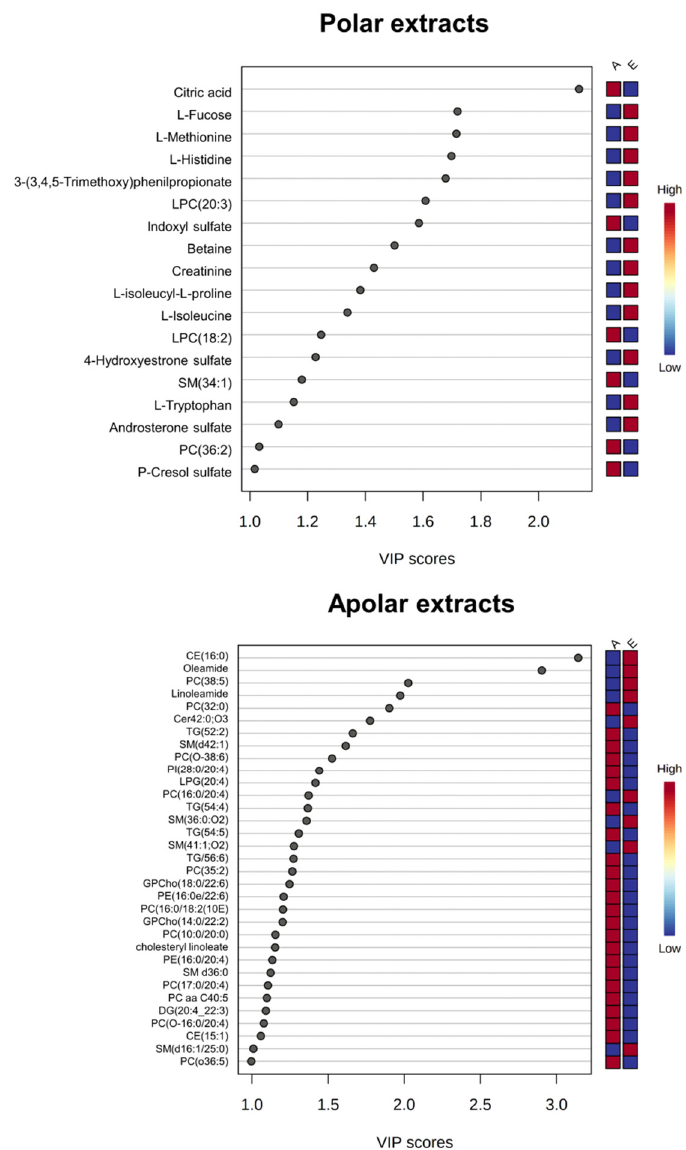
Figure 3. O-PLS-DA VIP graphs for the HRMS data collected using ESI (+) and ( − ). Data are relative to polar ( top ) and apolar ( bottom ) serum extracts of early compared to advanced ALS patients. The color code indicates higher (red) or lower (blue) concentrations in early (E) compared to advanced (A) ALS patients.